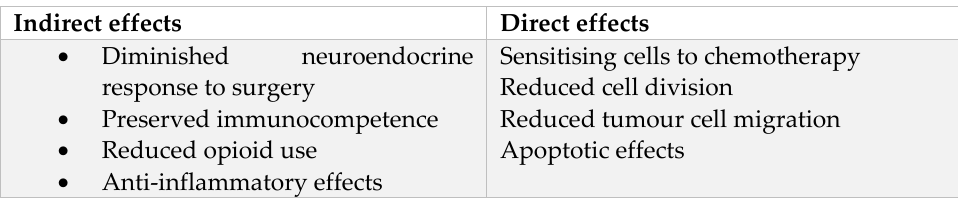
Figure 3. Indirect versus direct effects of local anaesthetics on tumour progression. Figure 4 below is a compilation of the vast array of mechanisms by which lidocaine exerts its effects on cancer